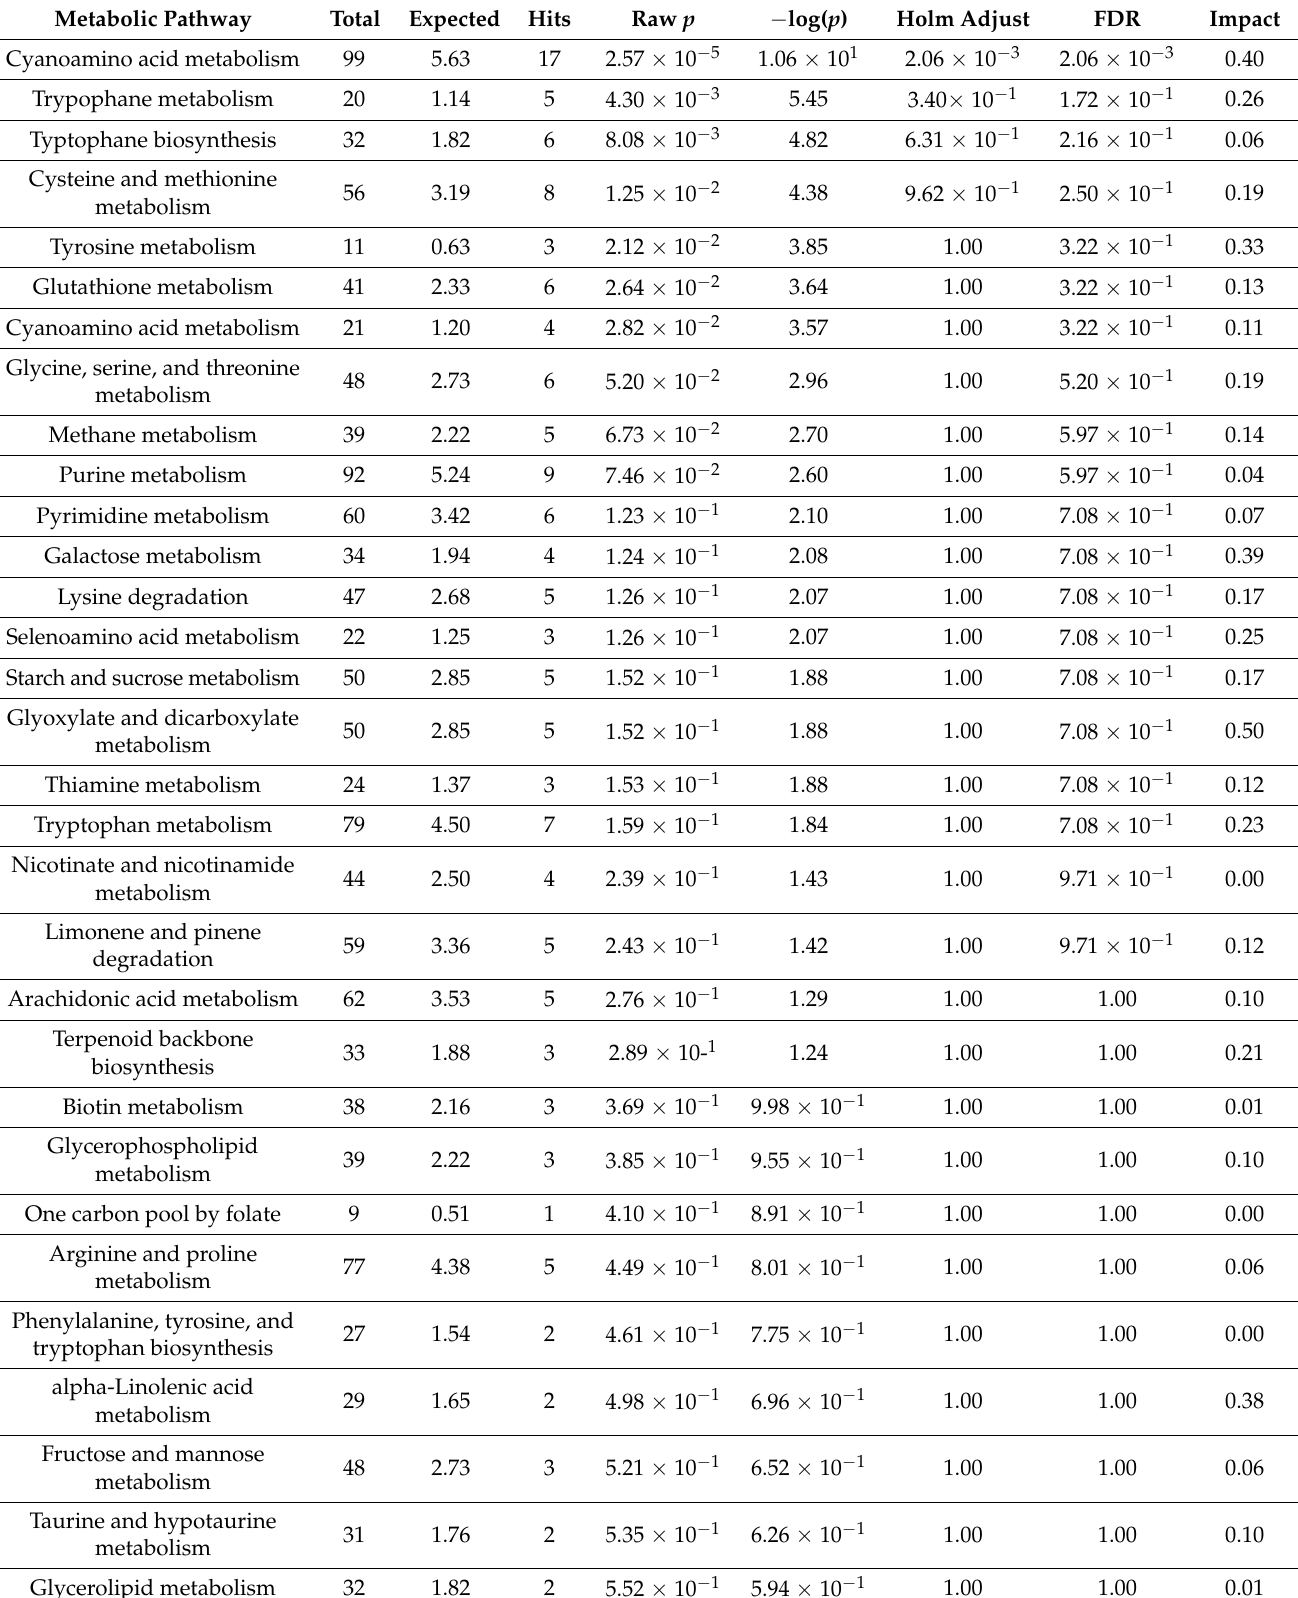
Table 3. The derivative pathway of digestate under anaerobic